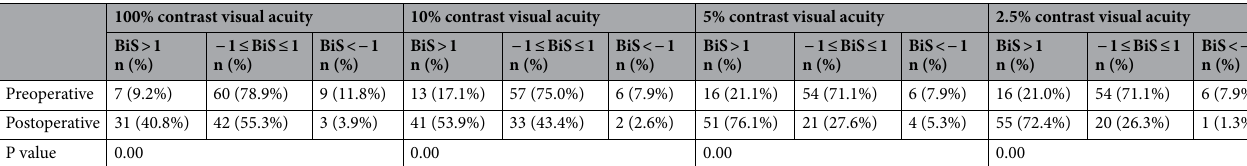
Table 1. The numbers and proportions of the patients with different BiS Scores before and after strabismic Surgeries. There were significant differences between preoperative proportions and postoperative proportions of the patients with different BiS for all contrasts (Fisher’s exact test). Pre-op preoperative, Post-op postoperative, n number, BiS binocular